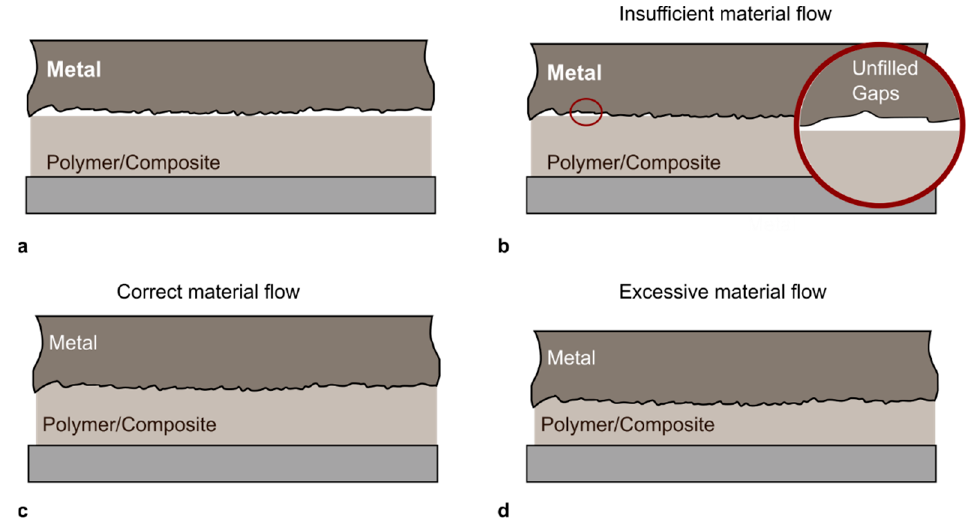
Figure 15. Schematic of the adherends surfaces: ( a ) Before joining; ( b ) Insufficient; ( c ) Correct and ( d ) Excessive material flow.